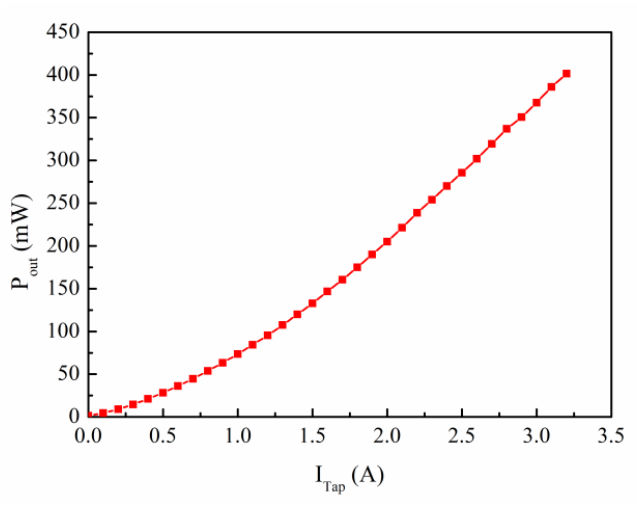
Figure 3. Measured output power with I DFB = 700 mA as a function of I Tap .